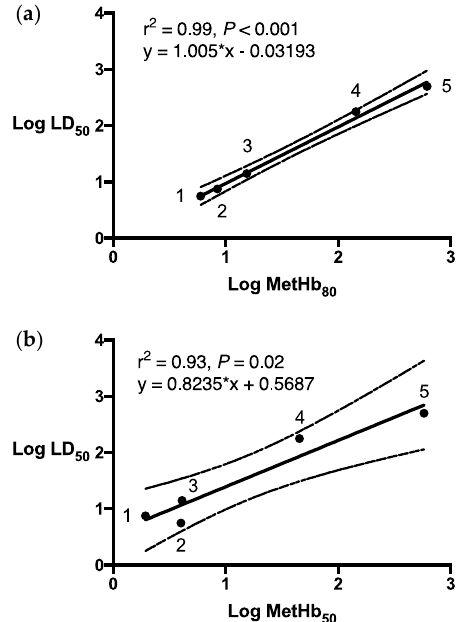
Figure 5. Comparison of log oral PAPP LD 50 for (1) feral cats, (2) dogs, (3) foxes, (4) laboratory rats and (5) brushtail possums against ( a ) predicted log 80% MetHb level (Log MetHb 80 ) and ( b ) log 50% MetHb level (Log MetHb 50 ) with 95% confidence.